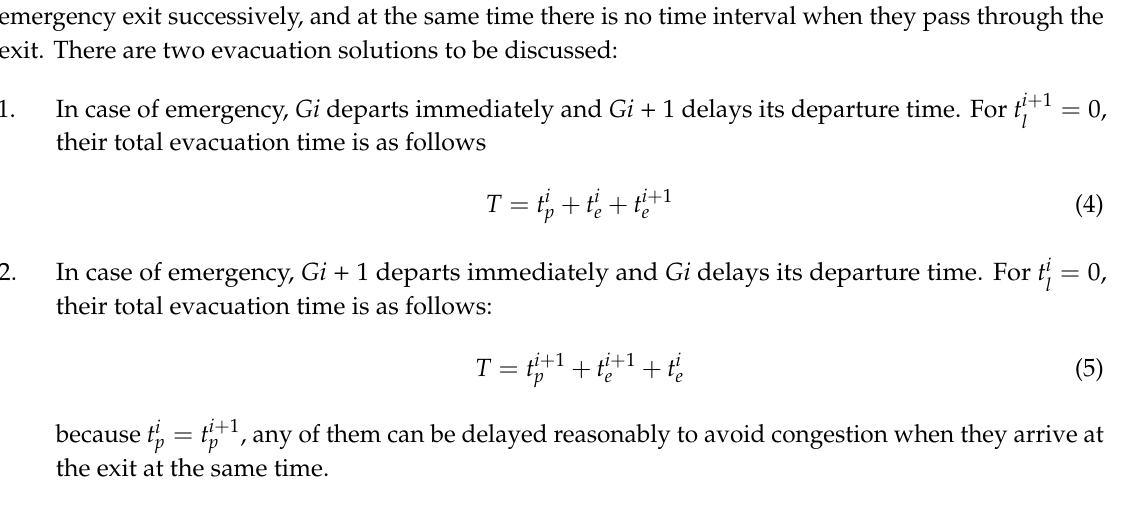
Figure 4. Two groups arrive at the emergency exit at the same time. Situation 3. Two groups set out at the same time and arrive at the exit successively, causing congestion. Assuming that Gi reaches E before Gi + 1, and Gi + 1 reaches E when Gi does not pass through the exit completely, as shown in Figure 5, the conditions for congestion of the two groups are 𝑡 𝑝 𝑖 <